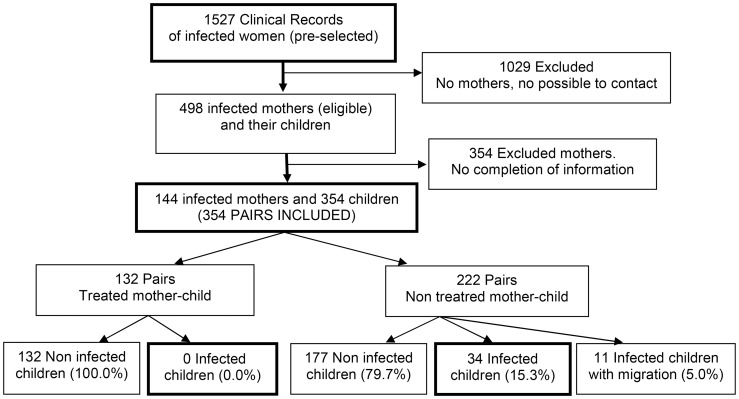
Flowchart of the study.